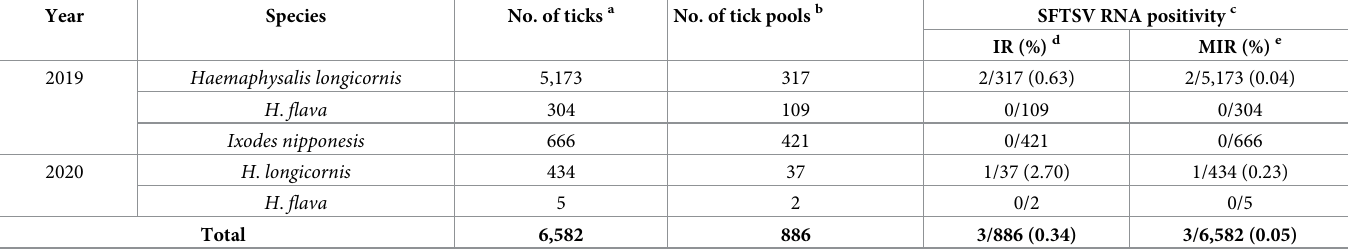
Table 3. Molecular prevalence of severe fever with thrombocytopenia syndrome virus (SFTSV) from ticks collected from Gyeonggi and Gangwon Provinces, Repub- lic of Korea, during